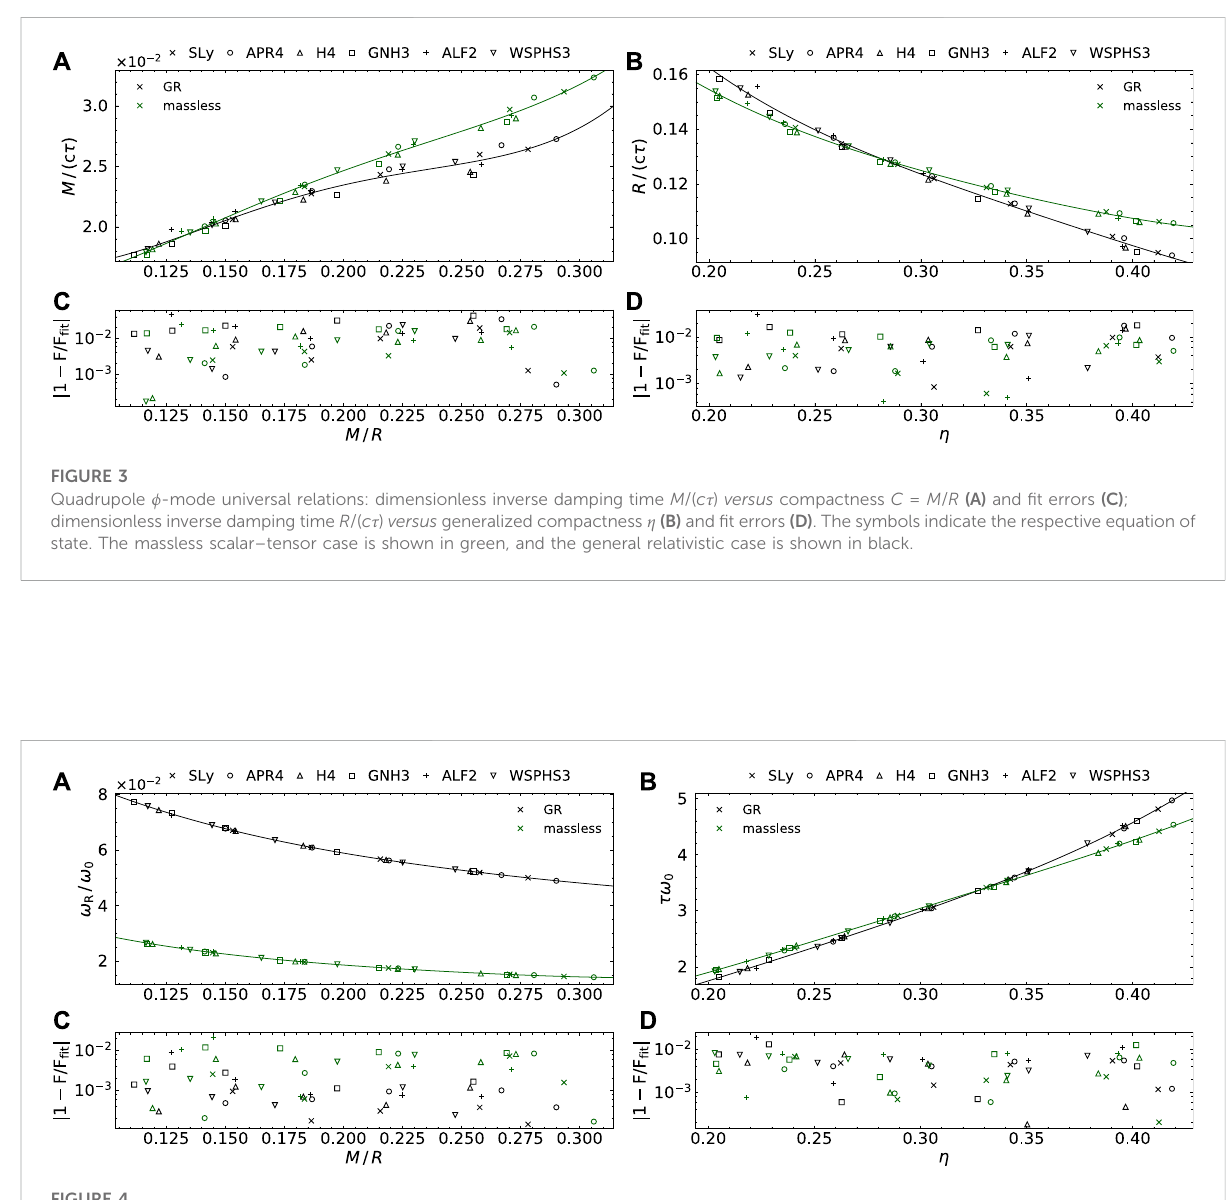
FIGURE 4 Quadrupole ϕ -mode universal relations: dimensionless frequency ω R / ω o versus compactness C = M / R (A) and fi t errors (C) ; dimensionless damping time τω o versus generalized compactness η (B) and fi t errors (D) . The symbols indicate the respective equation of state. The massless scalar – tensor case is shown in green, and the general relativistic case is shown in